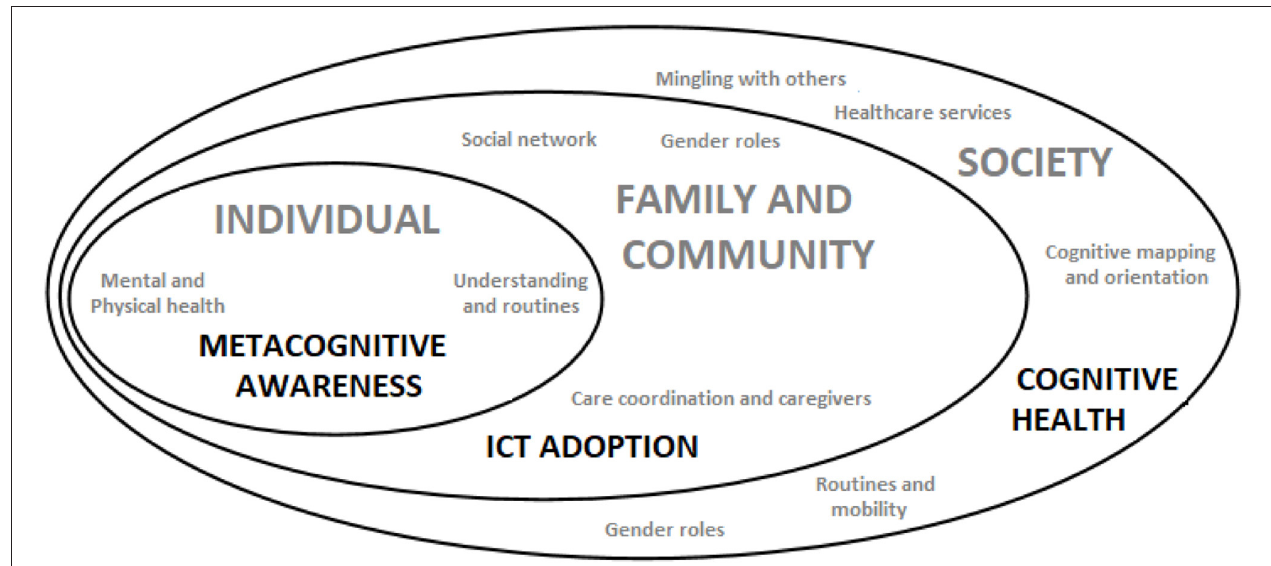
FIGURE 1 | A schematic approach across the individual, the family and community, and the system and society variables in older’s cognitive health, to keep the individual